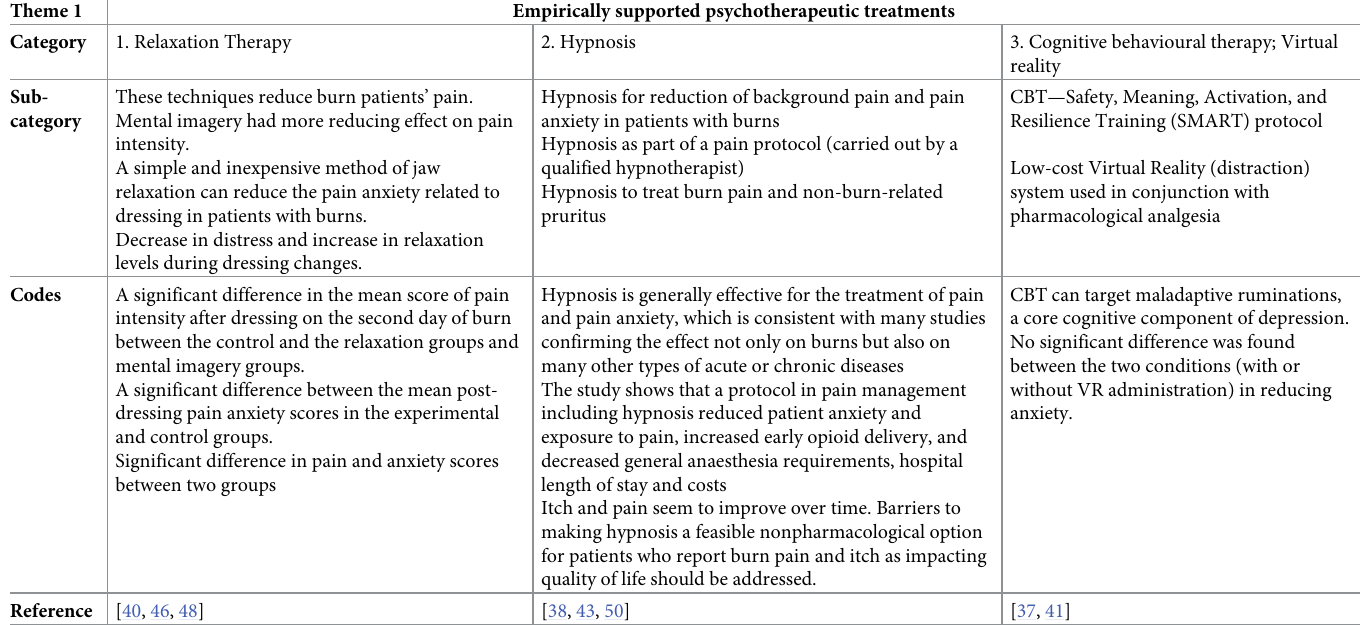
Table 4. Theme 1 empirically supported psychotherapeutic treatments.